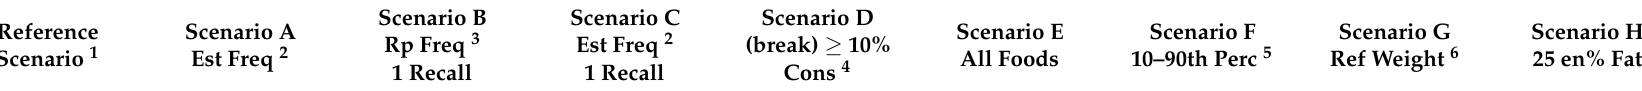
Table 6. Main changes in draft FBR and problem nutrients for Kenyan children 4–6 years of age caused by changes in dietary intake data, selection criteria and energy and nutrient requirement data.